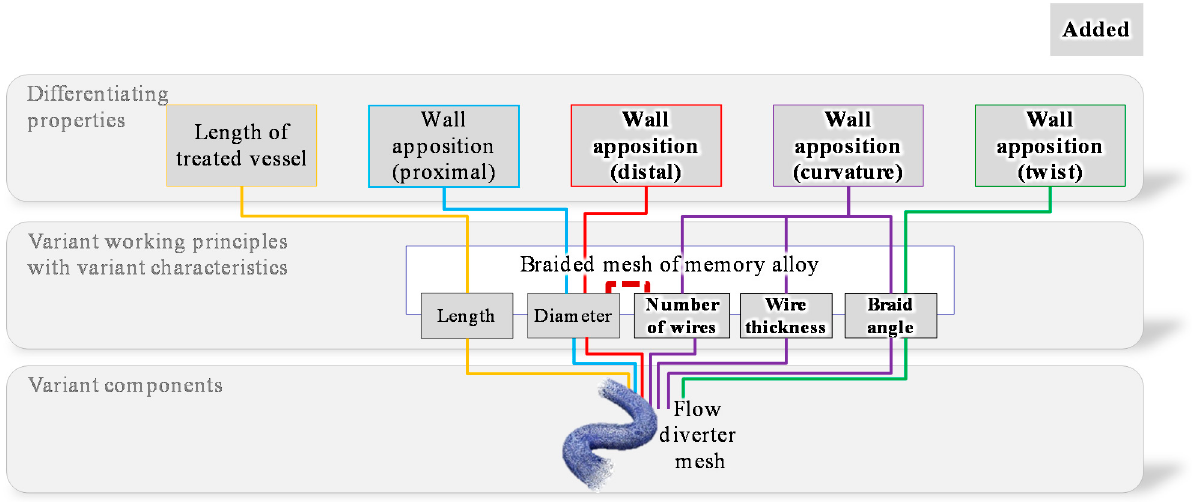
Figure 8. Revised 3-level VAM with added differentiating properties.